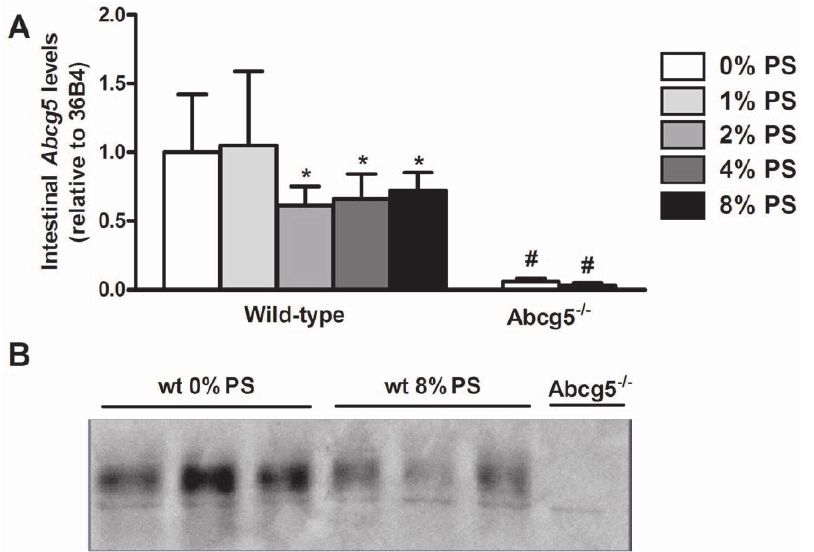
Figure 4. mRNA levels and protein expression of Abcg5 in wild-type and Abcg5 -/- mice fed mice fed either control or diet enriched with plant sterols. Values represent average 6 SD. n=4–11. * P , 0.05 control vs plant sterol fed wild-type mice; # P , 0.05 control vs plant sterol fed Abcg5 -/- mice.